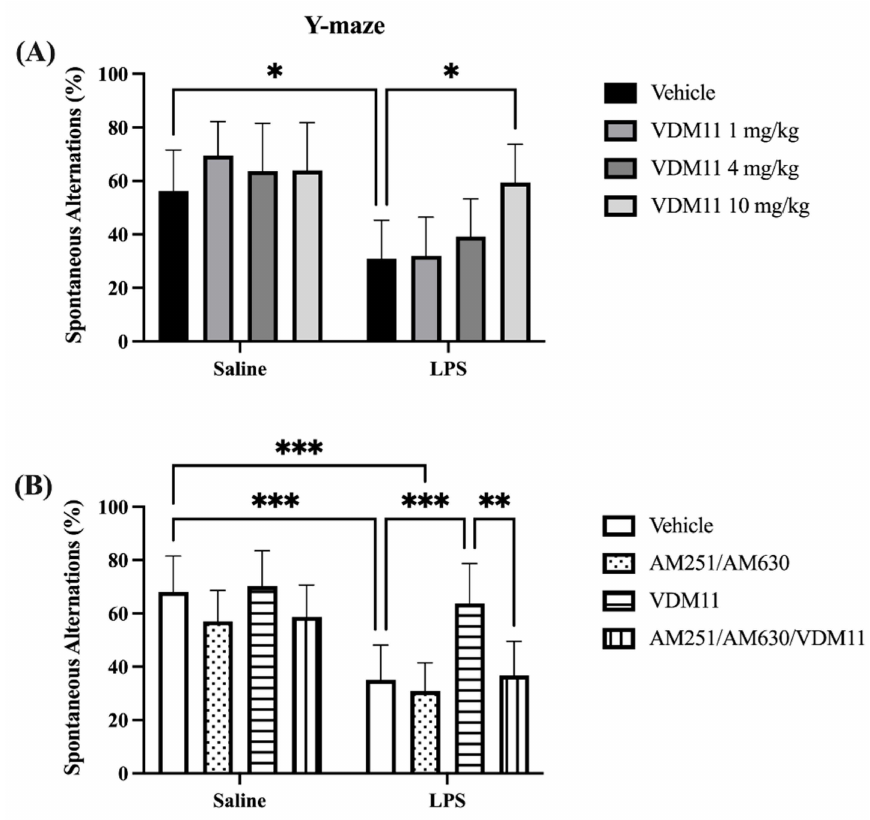
Figure 8. ( A ) In the Y-maze test performed on mice 26 h after LPS administration, VDM11 (an anandamide reuptake inhibitor; 10 mg/kg) significantly increased spontaneous alterations (%). ( B ) A combination treatment of 1 mg/kg each of the CB1 receptor antagonist AM251 and the CB2 receptor antagonist AM630 blocked the effects of 10 mg/kg of VDM11 on the percentage of spontaneous alternations that occurred during the Y-maze test 26 h after LPS administration in mice. * p < 0.05; ** p < 0.01; *** p <